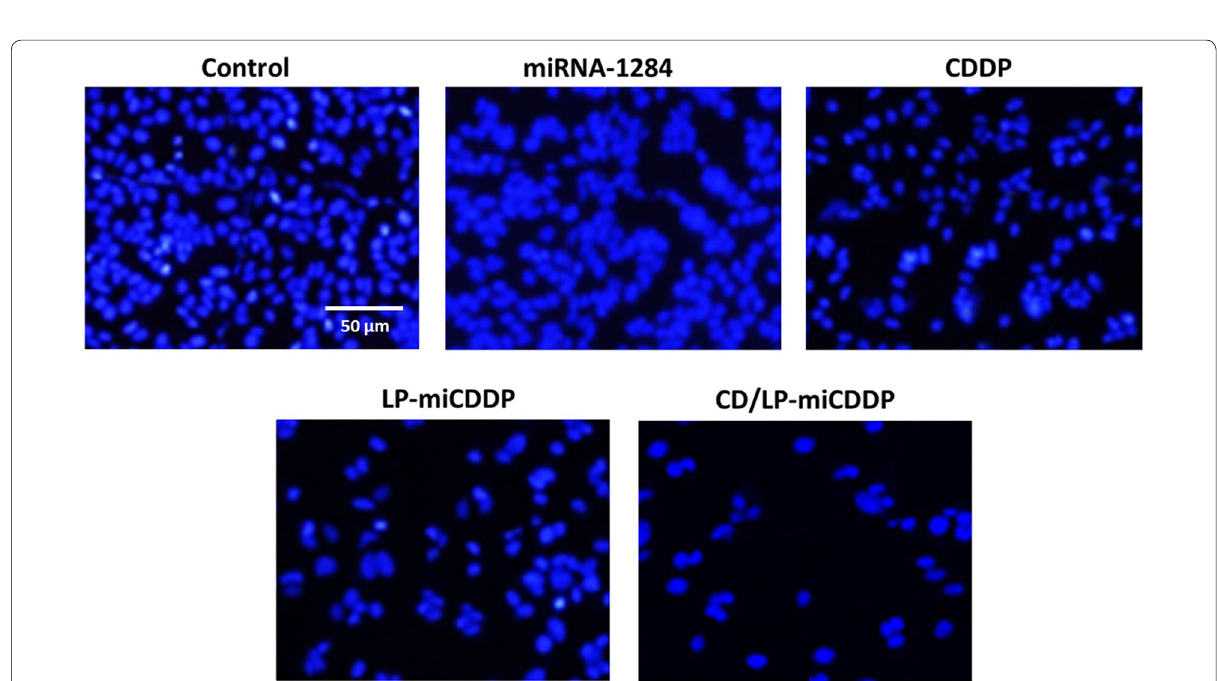
Fig. 6 Apoptosis analysis of HeLa cancer cells after treatment with miR‑1284, CDDP, LP‑miCDDP and CD/LP‑miCDDP using Hoechst 33342